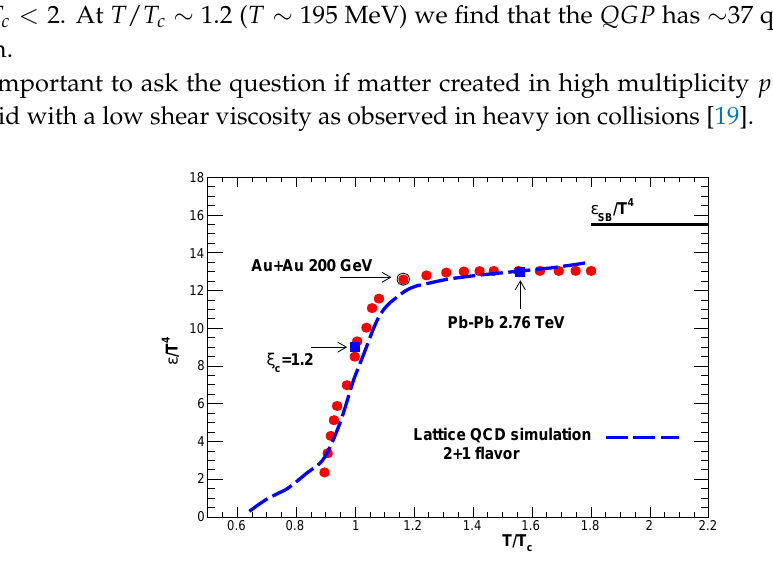
Figure 9. ε / T 4 versus T / T c from CSPM (red circles) and Lattice QCD (blue dash line) for 2 + 1 flavor and p4 action